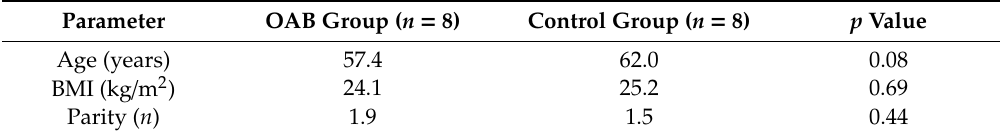
Table 1. Demographic data of the study